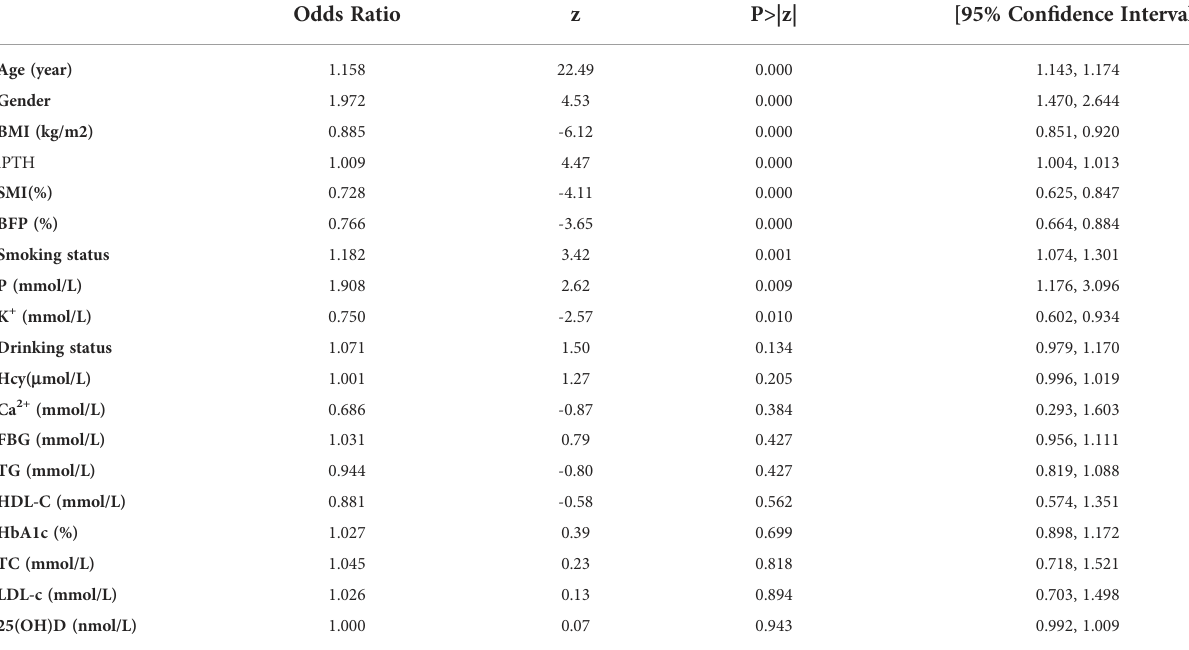
TABLE 2 Results of multiple logistic regression analysis (n=56,462)